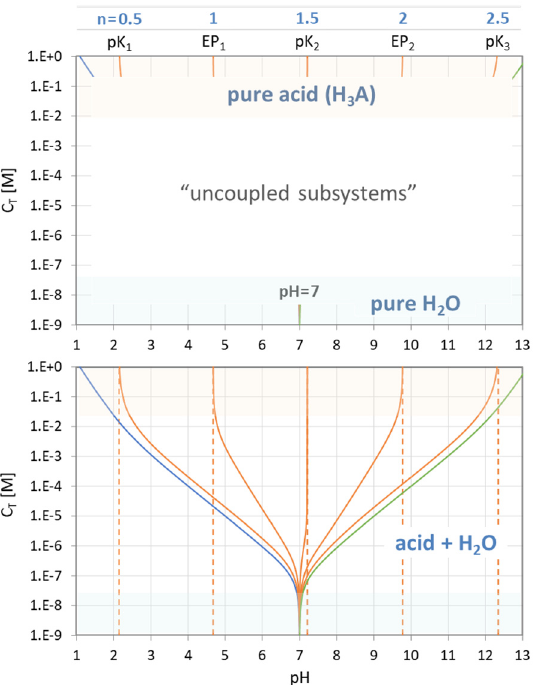
Figure 28. Trajectories of EPs and semi-EPs for phosphoric acid (H 3 PO 4 ) for the uncoupled ( top ) and coupled system ( bottom ).